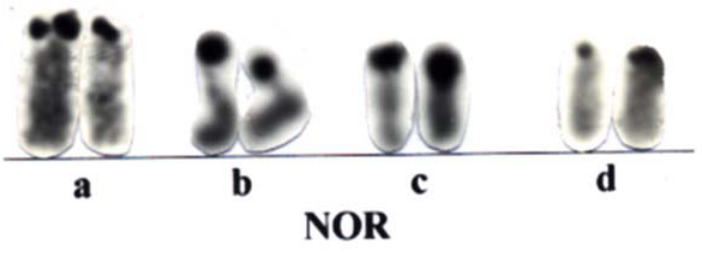
Fig. 7 – Localization of the Nucleolous Organizer Regions in the pair D1 in: A) D. prymnolopha ; B) D. leporina ; C) D. fuliginosa ; D) Dasyprocta